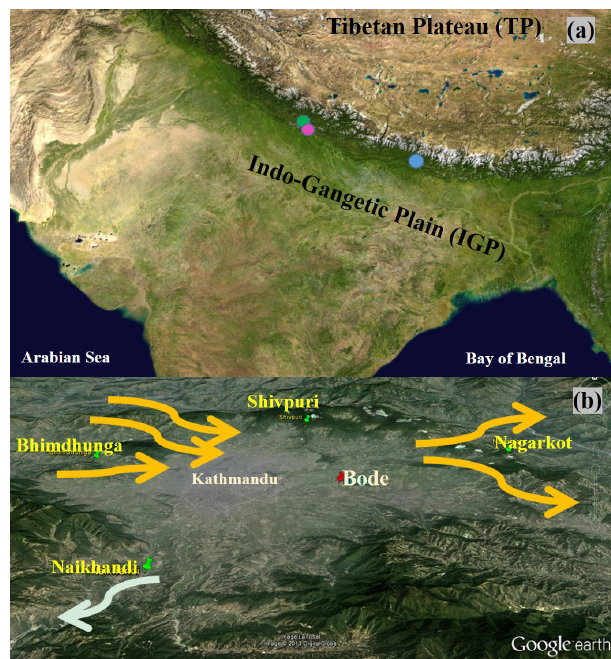
Figure 1. (a) Satellite image depicting the location of observation sites, namely, Bode (blue) in the Kathmandu Valley, Nepal, and Nainital (green) and Pantnagar (pink) in India during the SusKat field campaign. (b) Satellite image of the Kathmandu Valley (edge in view) with the super site (Bode) and four satellite sites (Bhimd- hunga, Naikhandi, Nagarkot and Shivpuri). Panel (b) also indicates the position of five mountain passes surrounding the valley (yellow arrows) and one river outflow location